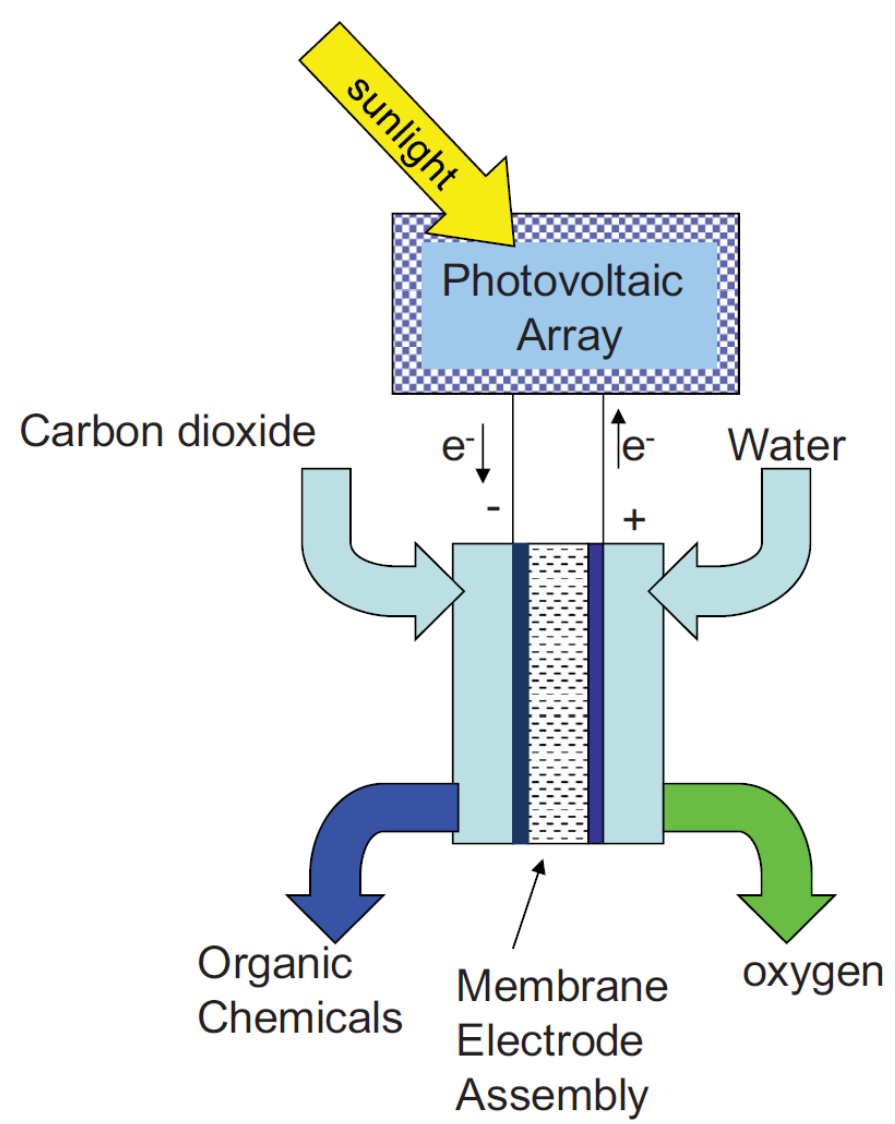
Figure 15. Polymer membrane cell configuration for the electrochemical reduction of carbon dioxide. Reprinted from Ref. [149], copyright (2010), with permission from the Electrochemical Society.